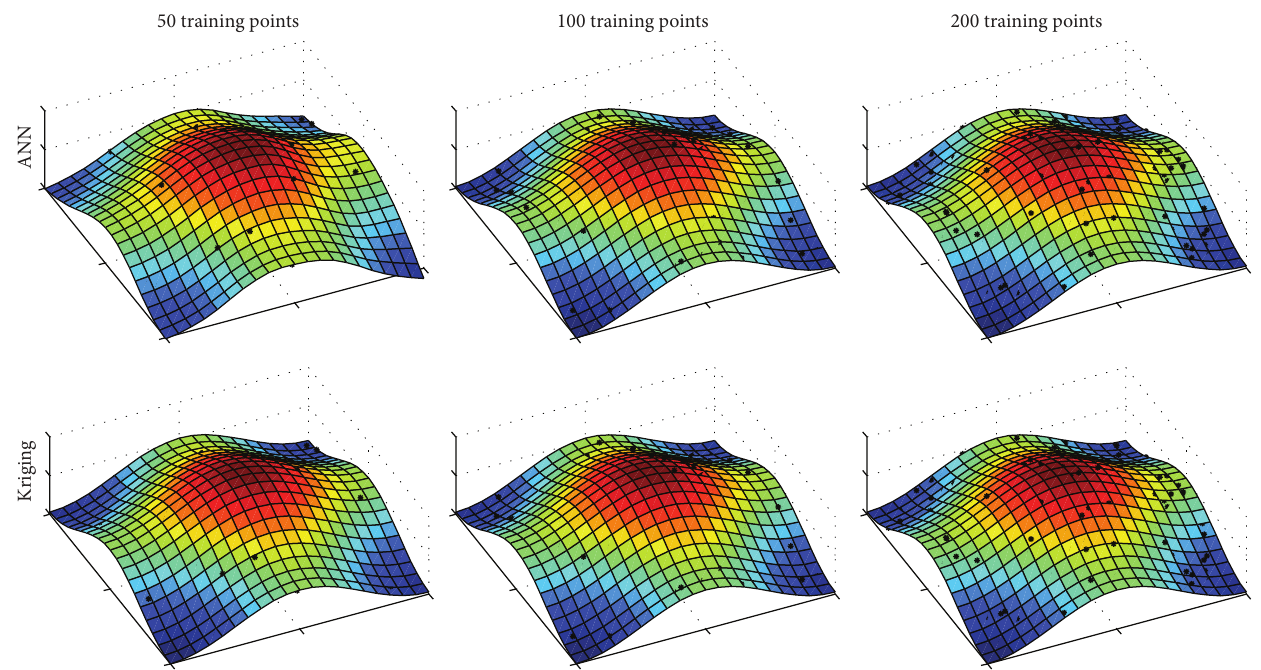
Figure 3: Metamodels of the Rastrigin function (9) obtained using the ANN and Kriging methods, based on 50, 100, and 200 experimental points.